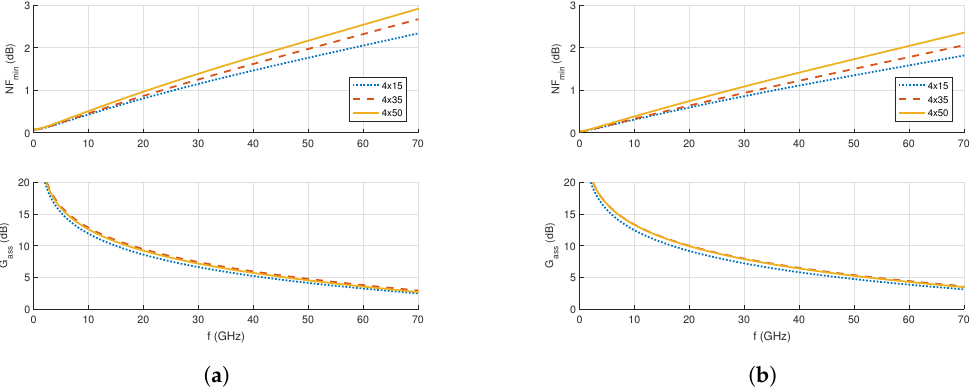
Figure 10. Minimum noise figure and associated gain extracted for 4x devices at V DS = 5 V, V GS ≈ − 1.25 V: ( a ) D01GH. ( b )